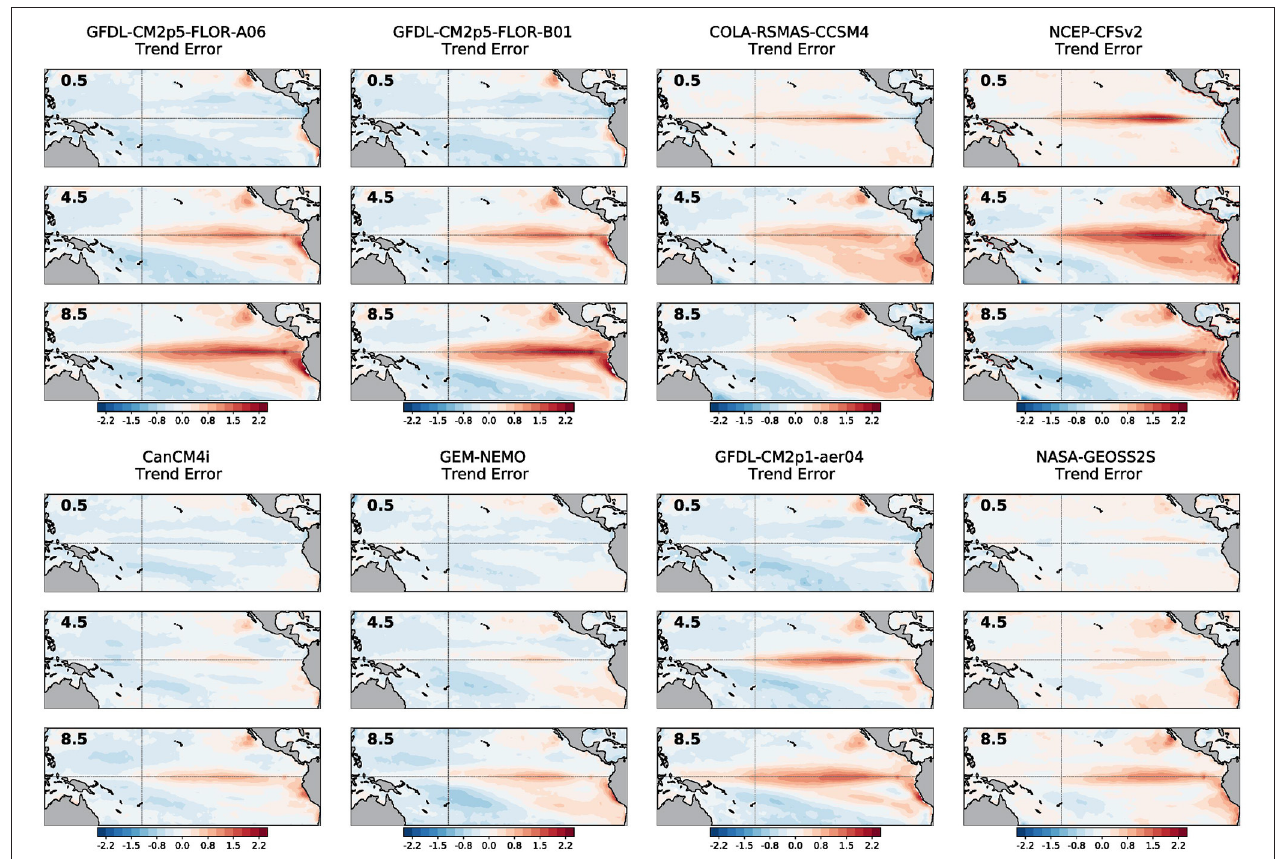
FIGURE 2 | For each model in the NMME, linear trend error (forecasted coefficient minus observed coefficient) in monthly sea surface temperatures from January 1982 to December 2020. The bold number in each panel shows the forecast lead time (0.5-, 4.5-, and 8.5-month leads). Units are in the degrees Celsius change over January 1982 to December 2020. The thin gray lines indicate the equator and the International Date